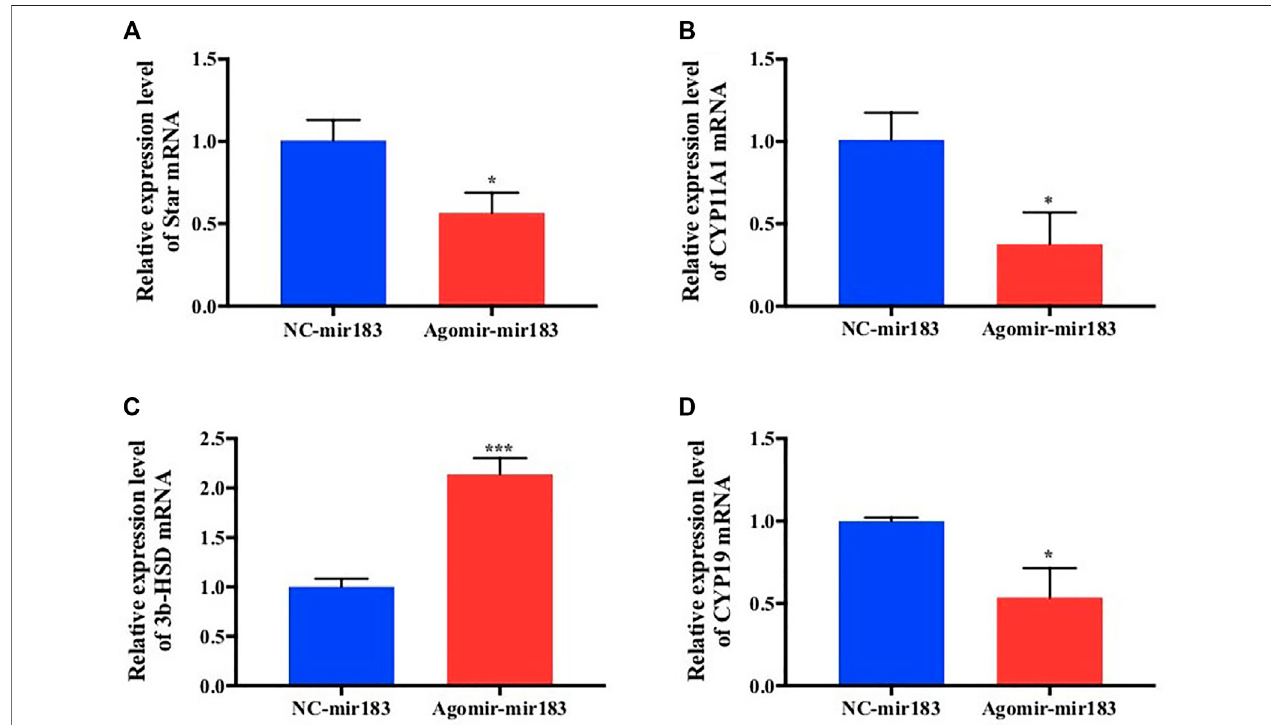
FIGURE 5 | Effect of overexpression of miR-183 on granulocyte cytokine synthesis (A – D) After mir-183 was overexpressed in granulosa cells, the mRNA expression levels of Star, CYP11A1, 3 β -HSD and CYP19 were measuerd by qPCR assay (*, p < 0.05; ***, p < 0.001, n (cid:1) 3).